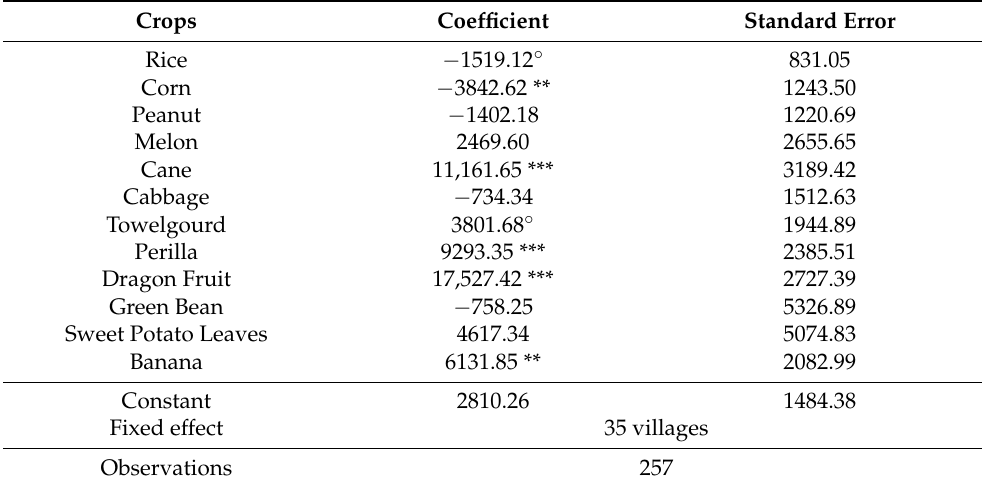
Table 4. Model results from a full model that included the proportion of the farm covered by 12 different crop